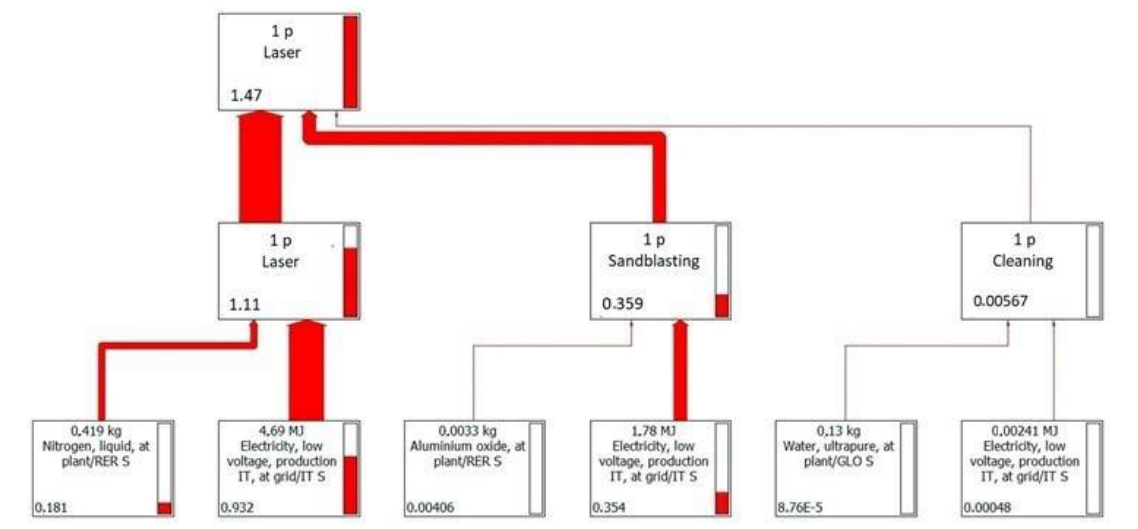
Figure 11. Life cycle of laser